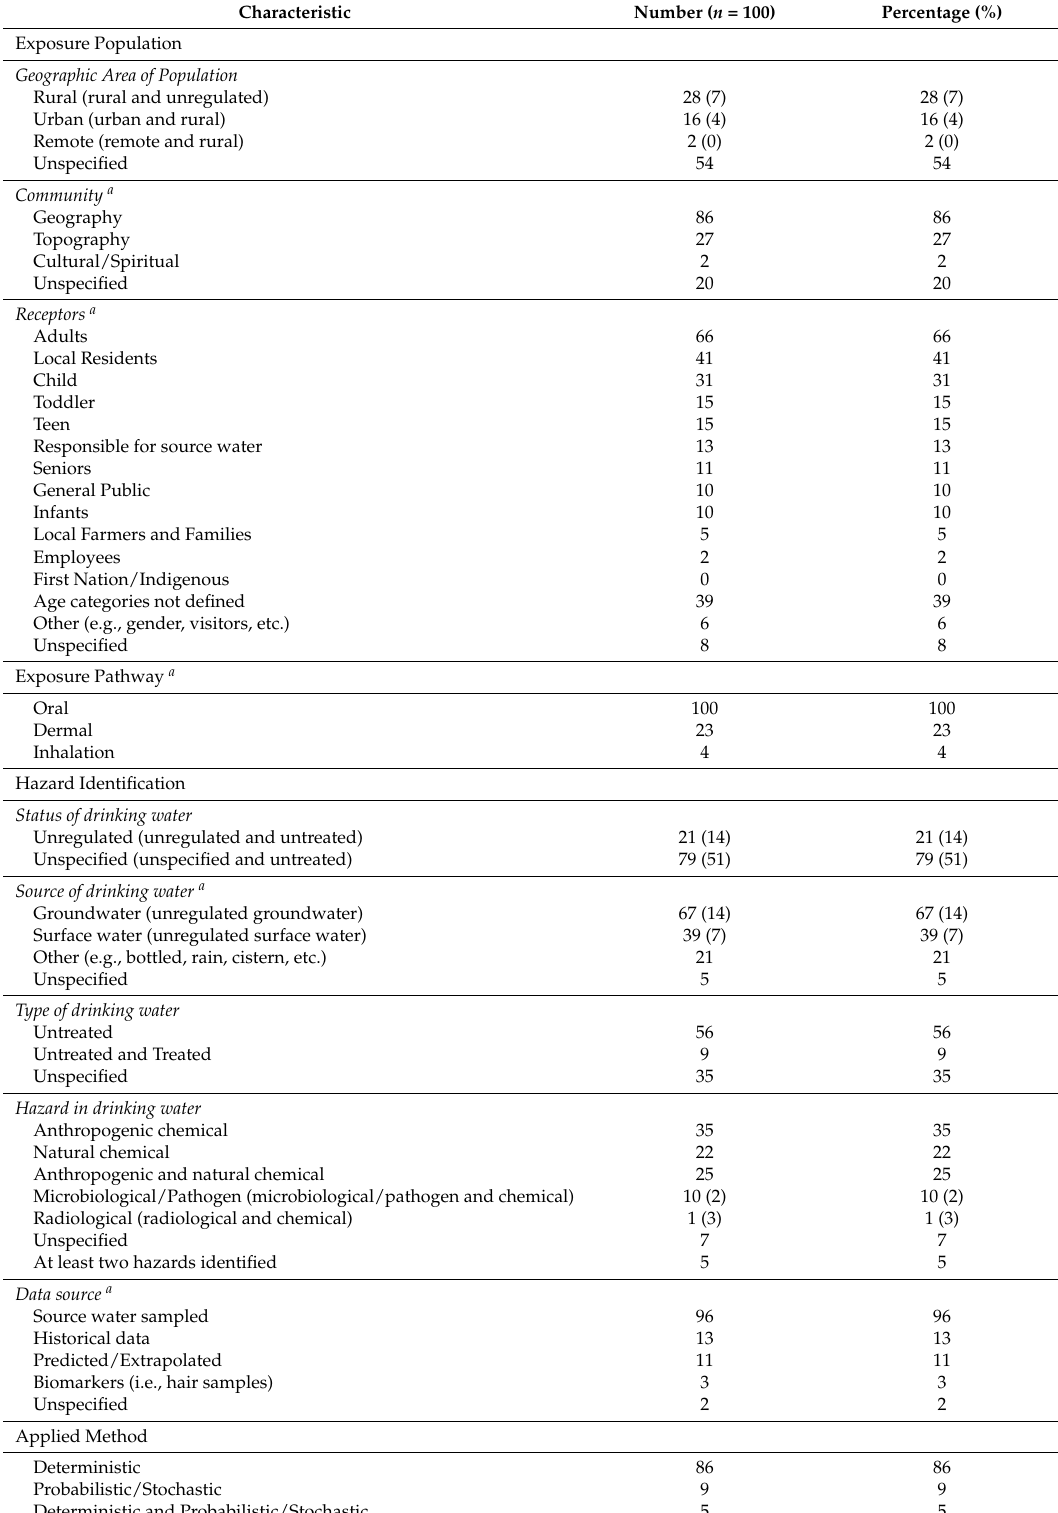
Table 2. Human health risk assessment characteristics from scoping review literature ( n =